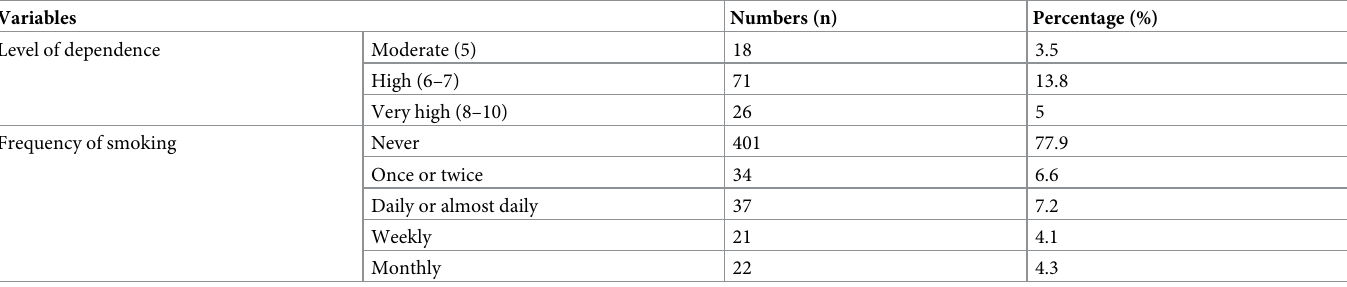
Table 3. Level of tobacco dependence and frequency of smoking amongst patients with schizophrenia attending their treatments at southwest Ethiopia, 2019 (n = 515).